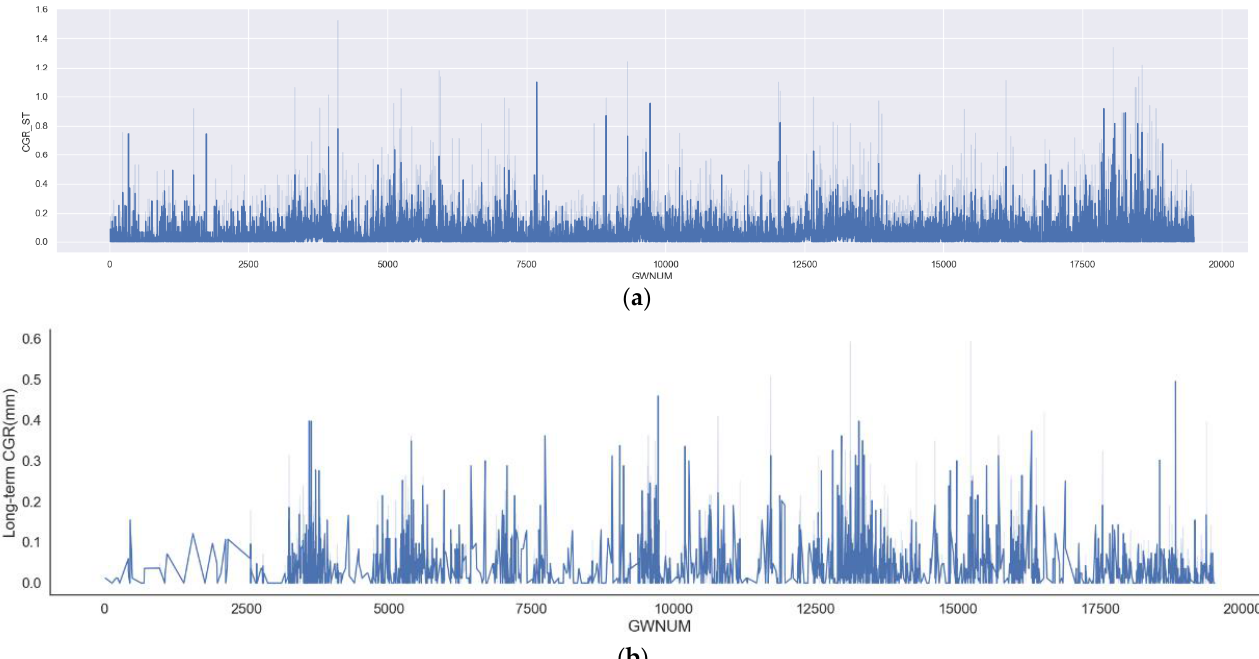
Figure 8. Corrosion Growth Rate (CGR): ( a ) short-term CGR (in mm) by GWNUM; ( b ) long-term CGR (in mm) by GWNUM.